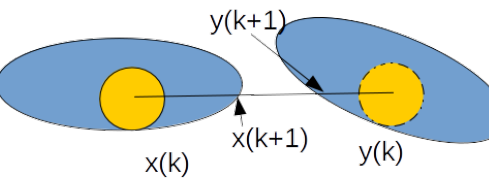
Figure 1. Illustration of the approach by